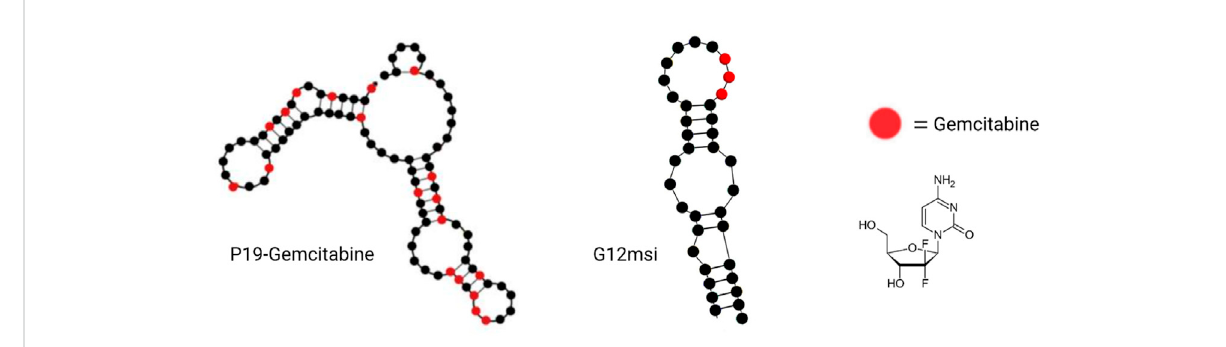
FIGURE 8 Examples of aptamer – gemcitabine conjugates. P19 – gemcitabine aptamer (left); G12msi aptamer (middle); and gemcitabine chemical structure